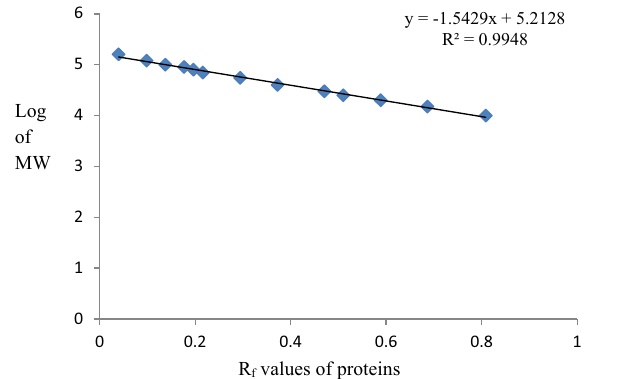
Figure 2. Calibration curve of the molecular weight